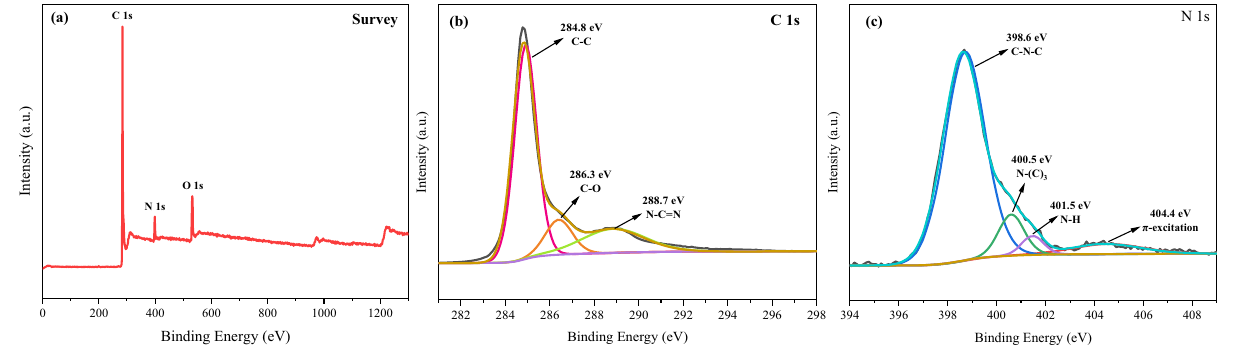
Figure 3: The XPS spectrum of GC - RGO - 1.5: ( a ) survey, ( b ) C 1s, and ( c ) N 1s.